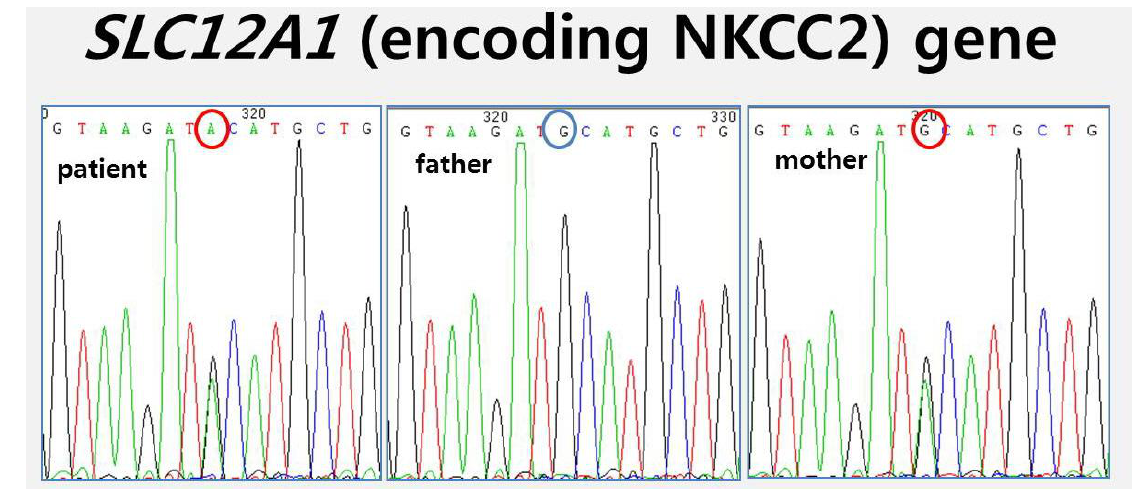
Figure 2. NKCC2 protein mutation sequencing revealed novel pathogenic mutations in the SLC12A1 gene, which was implicated in antenatal type I Bartter syndrome.